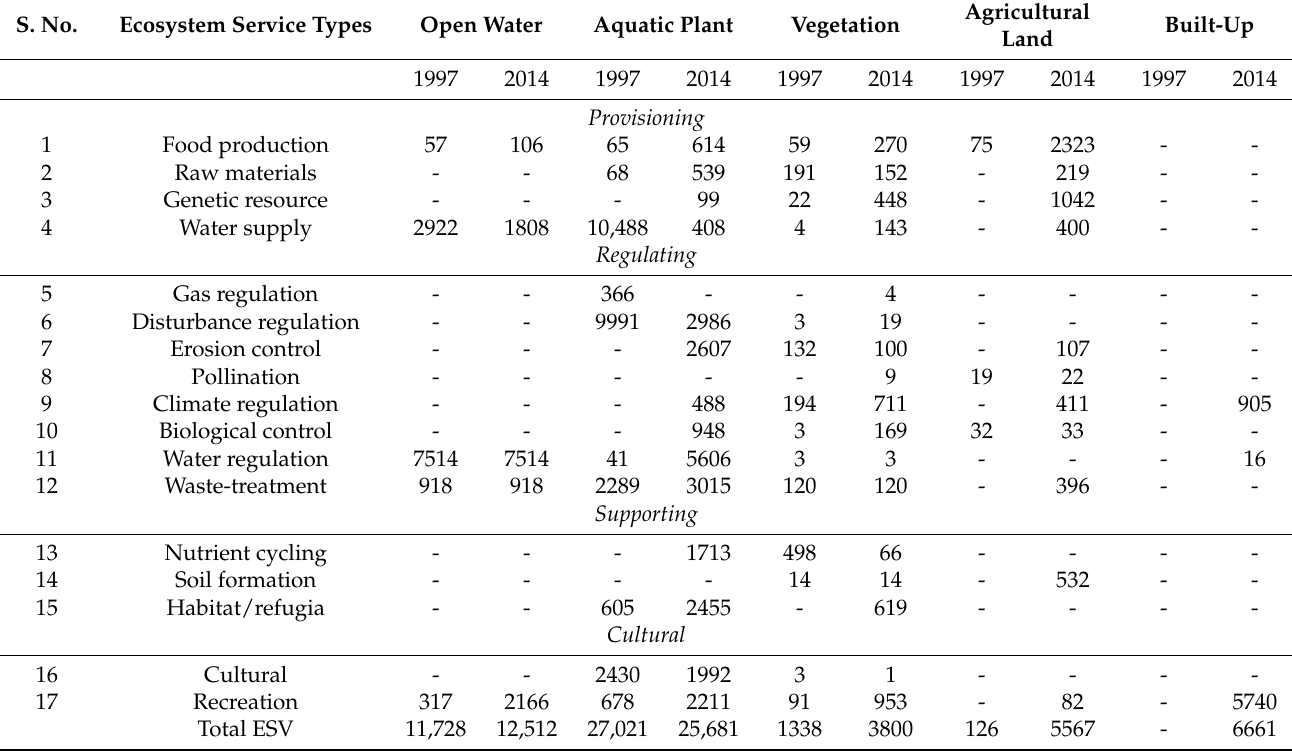
Table 3. Ecosystem services’ yearly value coefficients (in USD ha − 1 year − 1